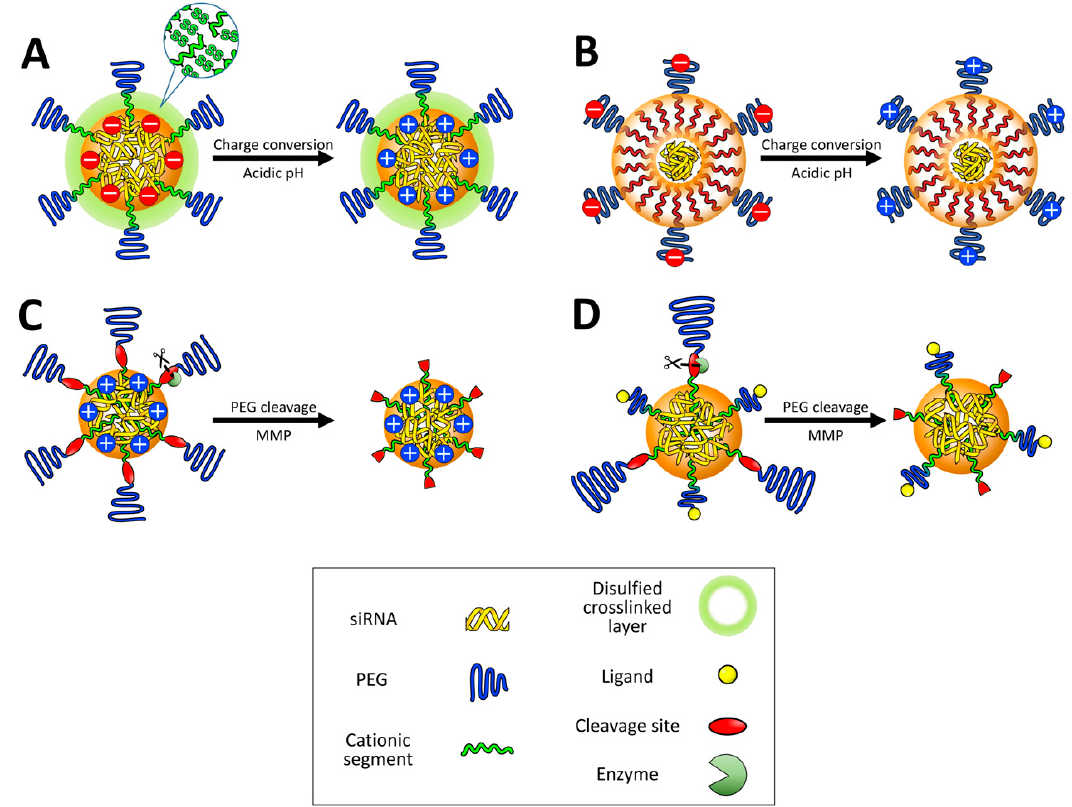
Figure 7. Multimolecular structures contain charge-conversion moieties in the core ( A ) or on to the surface ( B ); Enzymes e.g., (matrix metalloproteinases) cleave PEG layers, which exposes positive charges in the core ( C ) or cell-specific ligands ( D ) (Reproduced with permission from [18]. Copyright Elsevier, 2016).